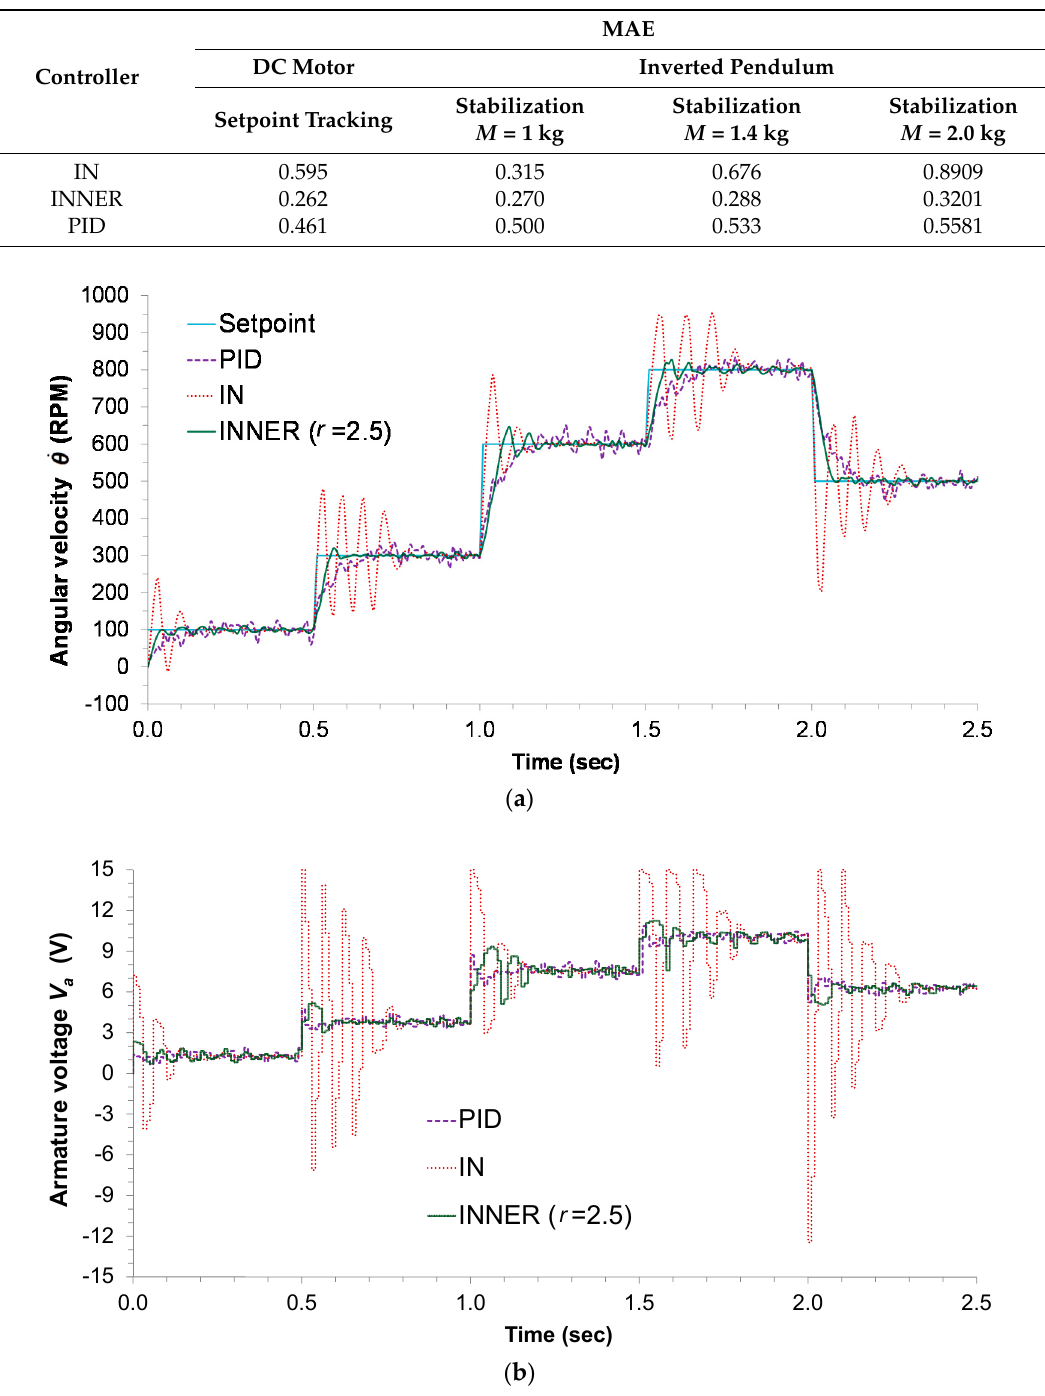
Table 3. Values for Mean Absolute Error (MAE) in the two case studies.